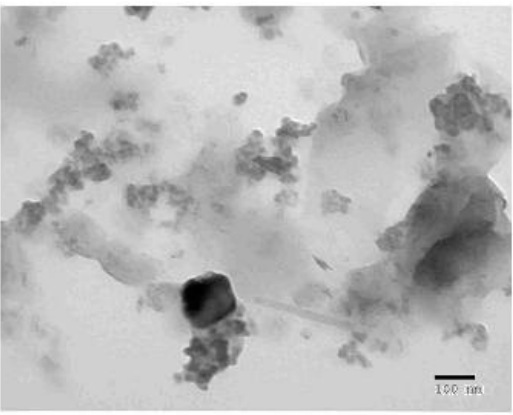
Figure 6. Transmission electron microscope (TEM) micrographs of the solid NH 4 [(VO)(FA)(AA 1 )] complex. Table 3. XRD diffraction patterns of the solid NH 4 [(VO)(FA)(AA 1 )] complex. Vanadium FAH 2 AA1 Metal